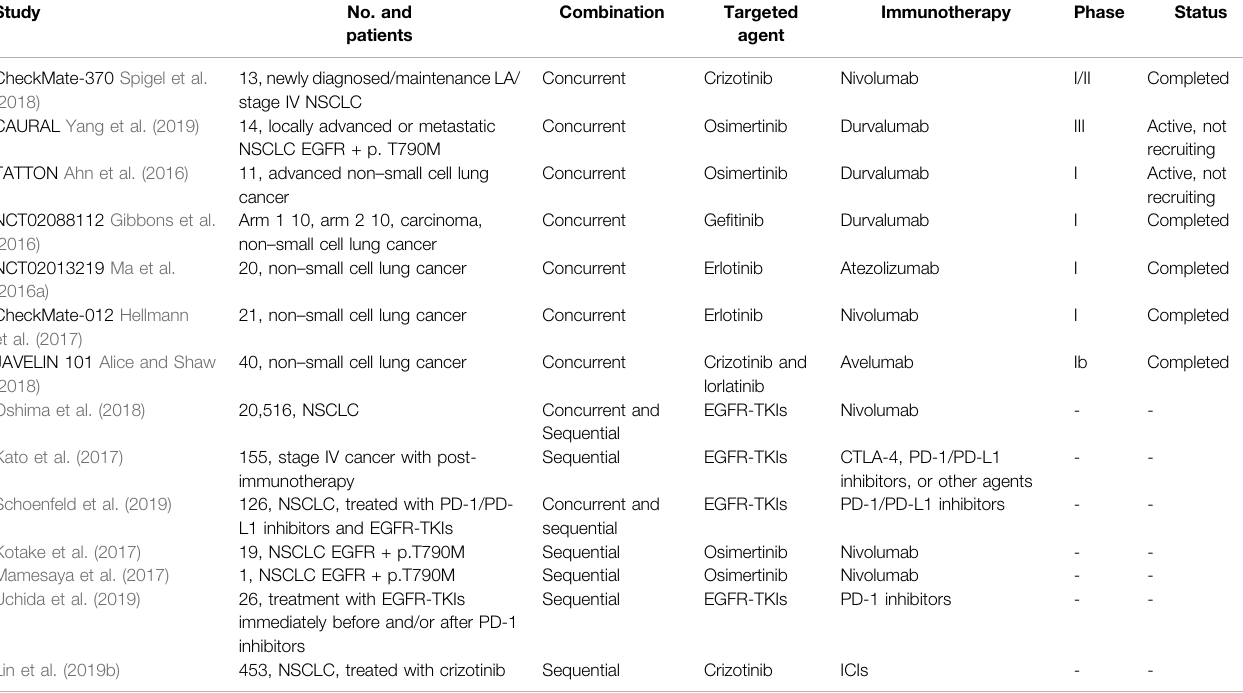
TABLE 1 | Prospective studies evaluating the ef fi cacy of combination or sequential ICIs and TKIs.